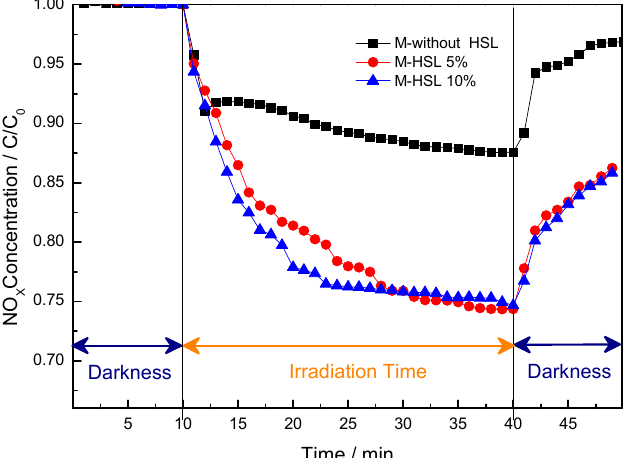
Figure 7. NO gas concentration profile evolution measured during the photochemical test, in flooring mortar samples.